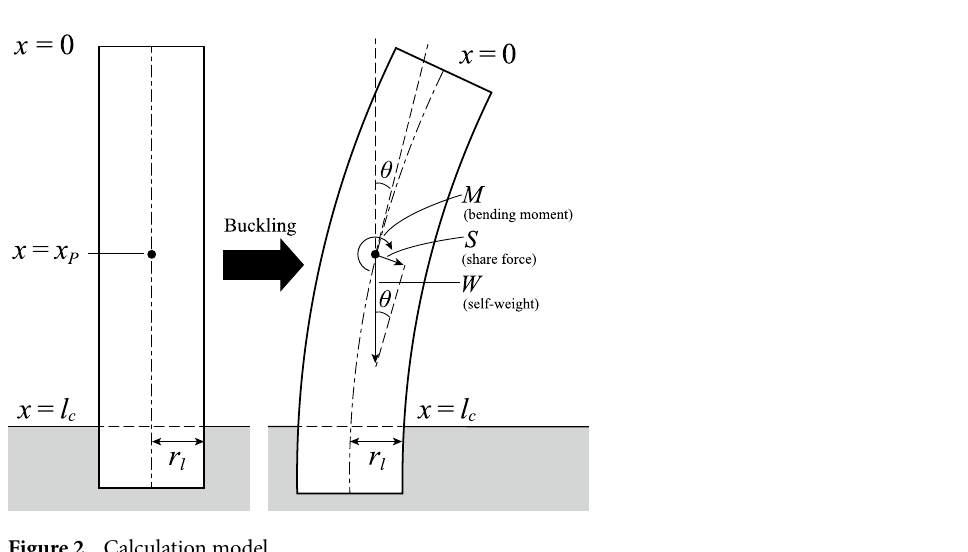
Figure 2. Calculation